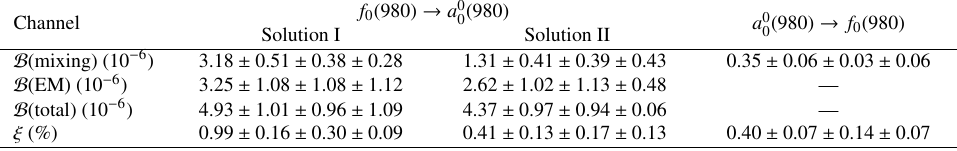
Table 1. The branching fractions ( B ) and the intensities ( ξ ) of the a 0 (980)- f 0 (980) mixing. The first 0 uncertainties are statistical, the second ones are systematic, and the third are related to (980) and f 0 (980). parameterization of a 0 0